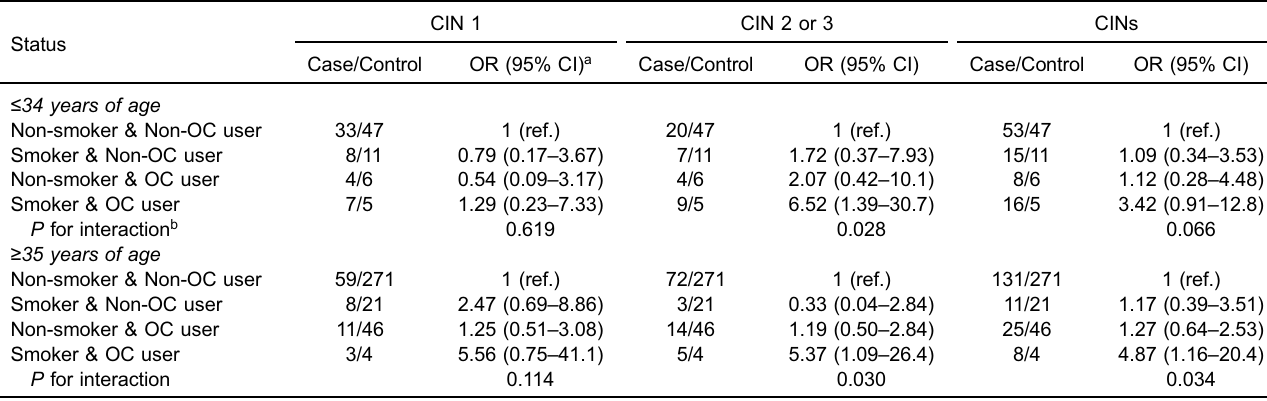
Table 4. Odds ratios of combination of oral contraceptive use and smoking status for cervical intraepithelial neoplasia when strati fi ed as two groups of <35 and ≥ 35 years of